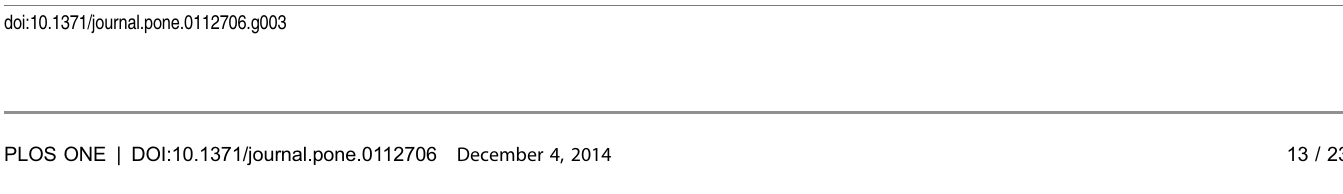
Figure 3. Boxplot of C T values of candidate reference genes during light/dark cycling, temperature fluctuation, and continuous darkness. A line across the box depicts the median. The box indicates the 25th and 75th percentiles. Whiskers represent the 90th and 10th